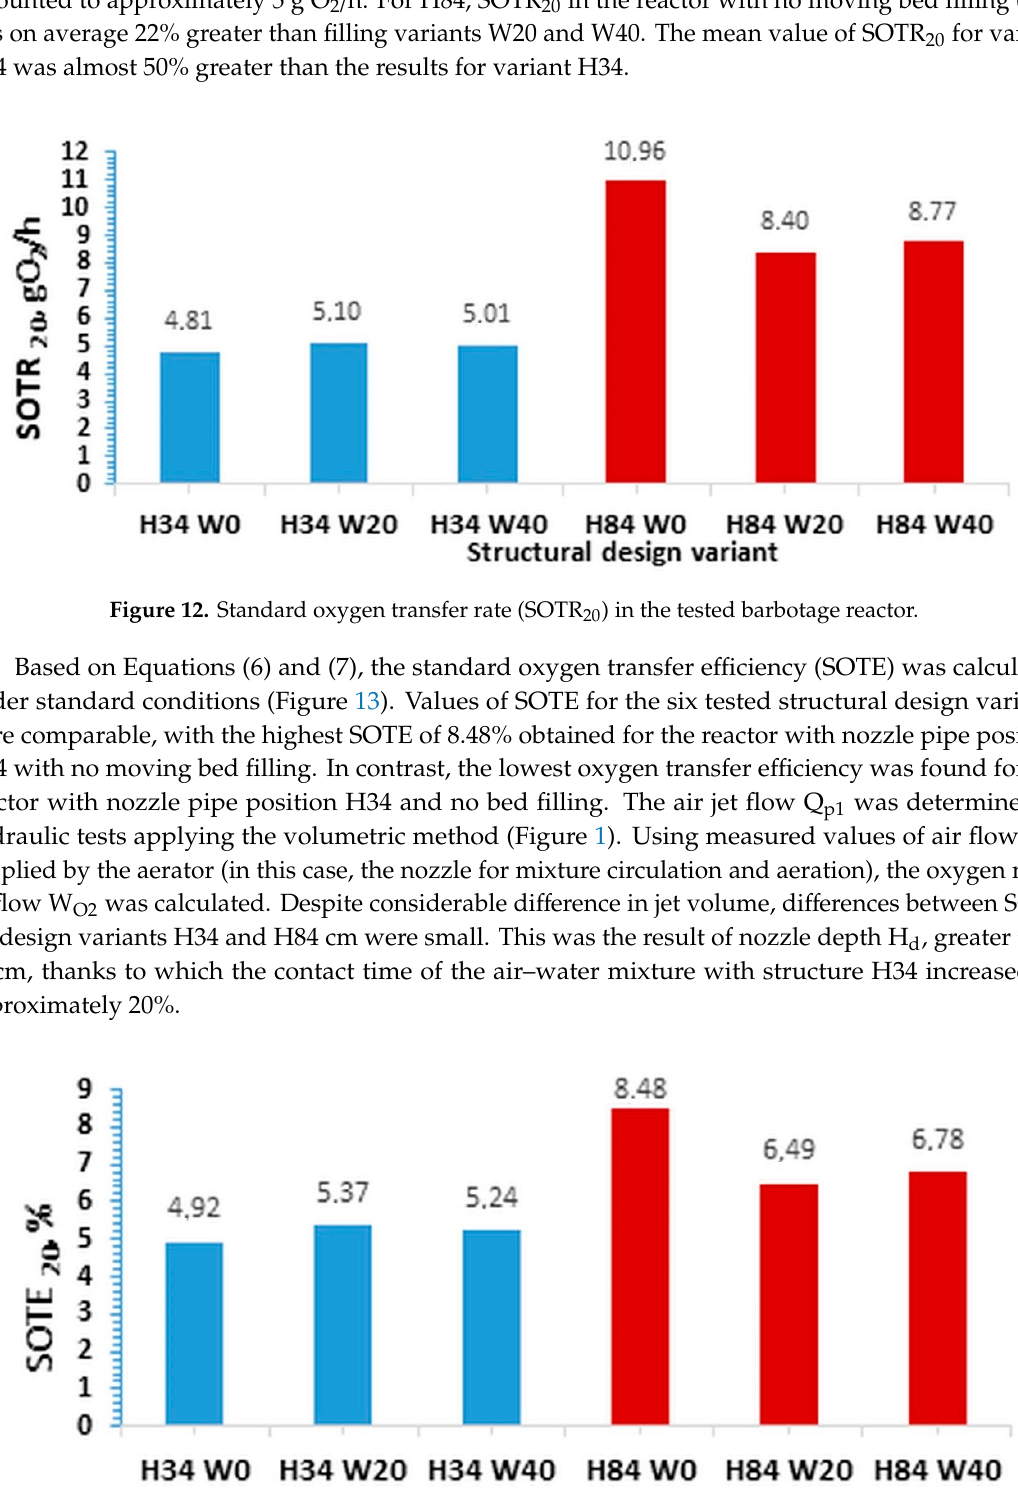
Figure 14. Standard aeration efficiency (SAE) in the tested barbotage reactor . 4.3. Statistical Analysis of Research Results Statistical analysis of the results was conducted in order to confirm the significance of observed differences between individually tested design variants of the hybrid reactor and the reactor filling rate with the moving bed. The analysis of variance in simple classification was applied to confirm the effect of nozzle position H and moving bed filling W on aeration conditions by testing the significance of differences in the means (Table 2). In the statistical analysis of the results, the significance level was adopted at α = 0.05. Based on the results from the analysis of variance, the height of the aerating nozzle H above the reactor bottom at an identical moving bed filling rate W had a significant effect on oxygenation capacity OC (Table 2). For the nozzle located at H34 and for all the analyzed moving bed filling variants W, the OC values did not differ significantly; for the nozzle pipe at height H84, there were no differences between the reactor filling with the moving bed W = 0% and 20%.